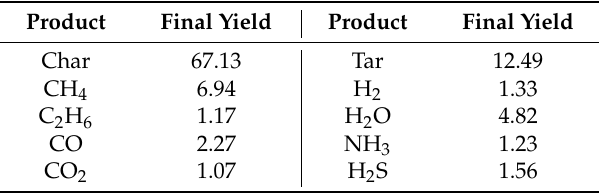
Table 4. The final yields of volatile matter (wt % daf